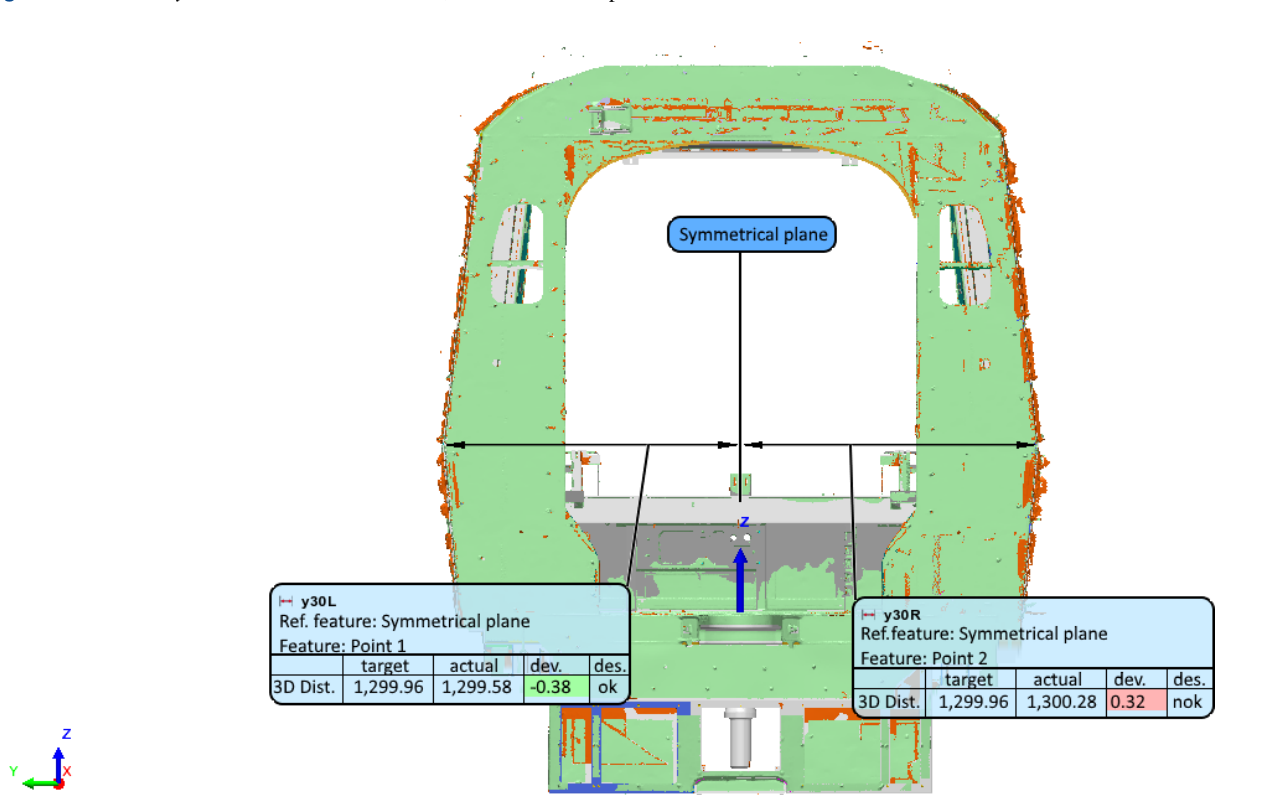
Figure 6. Additionally calculated vehicle’s central plane (plane of symmetry) and the related width dimensions, i.e. y